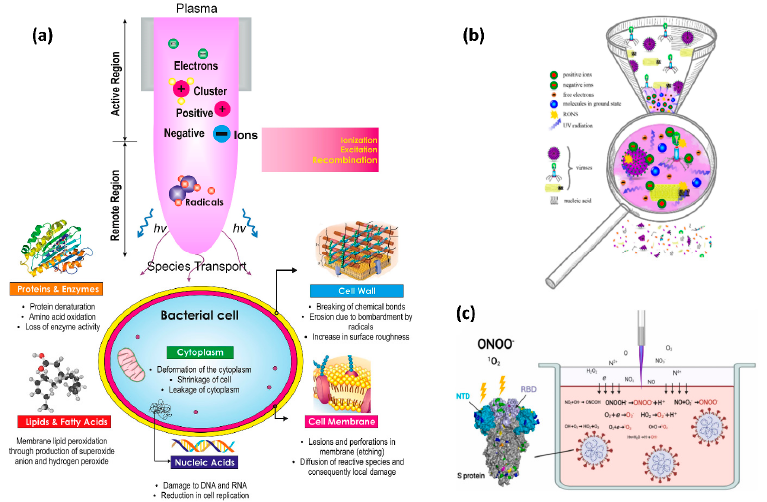
Figure 2. ( a ) A diagram depicting the action of cold plasma on microbial cell structures, resulting in functional loss and sterilization [54]. ( b ) The mechanism of viral inactivation by plasma [55]. ( c ) The mechanism through which RONS produced in Ar-based NBP damage S protein. Plasma jet-gener- ated reactive species dissolve into liquid and cross-react in the liquid phase. Predominant RONS ONOO- and O2- oxidized tyrosine, tryptophan, and histidine at RBD and NTD, thereby impair RBD's capacity to bind to cell receptor ACE2 and NTD's function. After 3 minutes of cold atmos- pheric plasma (CAP) or NBP treatment, the viral genome remains intact. Reprinted with permission from [56]. 3.2. Thermal and Nonthermal Plasma Two basic groups of plasma systems are typically characterized: thermal plasmas and non-thermal plasmas, in which the temperatures of the various plasma species differ. Due to growing interest in industries like aerospace, microelectronics, automotive, mate- rial processing, metal melting and welding, plasma chemical synthesis, vapor deposition, plasma, arc spraying, and waste destruction during the past few decades, thermal plasma technology has advanced [57]. The major phenomena involved in typical atmospheric plasma devices are Joule heating and thermal ionization [57]. These devices are made pos- sible by arcs or radio frequency (RF) inductively coupled plasma discharges. The main limitations of thermal plasmas include low excitation selectivity and extremely high gas temperatures, as well as stringent quenching requirements and electrode issues that re- strict the energy efficiency and practicality of thermal plasma sources. Thermal plasmas are nearly fully ionized plasma in which all particles have about the same temperature. Thermal plasma was also known as hot plasma or equilibrium plasma. Based on the de- mands, the equilibrium plasma was used in a variety of applications [58,59]. On the other hand, nonthermal plasma contains light electrons, which have much higher temperatures than heavy atoms and molecules and are often close to room temperature. Due to their high selectivity in plasma chemical processes and their ability to function well at low tem- peratures without quenching, non-thermal plasmas, such as low-pressure glow and RF, microwave discharges, dielectric barrier discharges, and laser-produced plasmas, have been used. Non-thermal atmospheric pressure plasmas have more recently been re- searched for a range of industrial and medical applications and are known as NBP or plasma medicines [58,60–66]. The NBP was also known as a cold plasma or non-equilib- rium plasma. NBP is appropriate for treating a wide range of biological materials, includ- ing solids, liquids, and aerosols because it is at room temperature at the site of application.